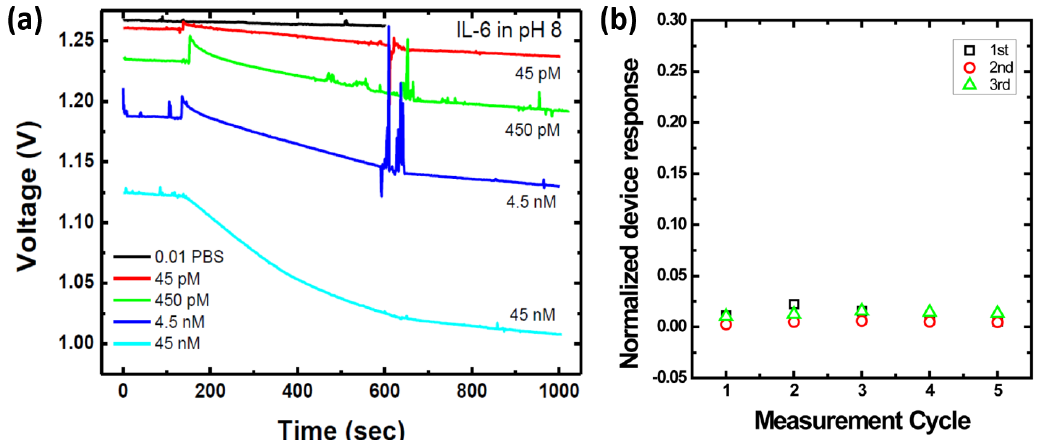
Figure 2. ( a ) A real-time experimental data of IL-6 measurement in PBS buffer solutions; ( b ) the experimental evaluation of base-line drift and noise of the sensor devices ( n = 3). The sensing response of each chip was recorded five times, i.e., the buffer was washed and data were recorded. The result shows that NDR obtained in Figure 2a is attributed to specific binding of biomolecules.